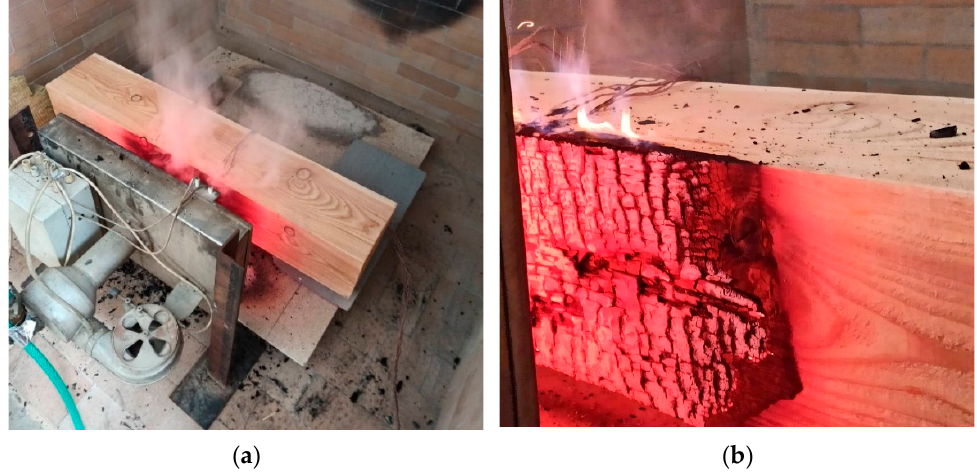
Figure 3. Medium-scale fire tests: ( a ) test equipment and ( b ) laminar flames.